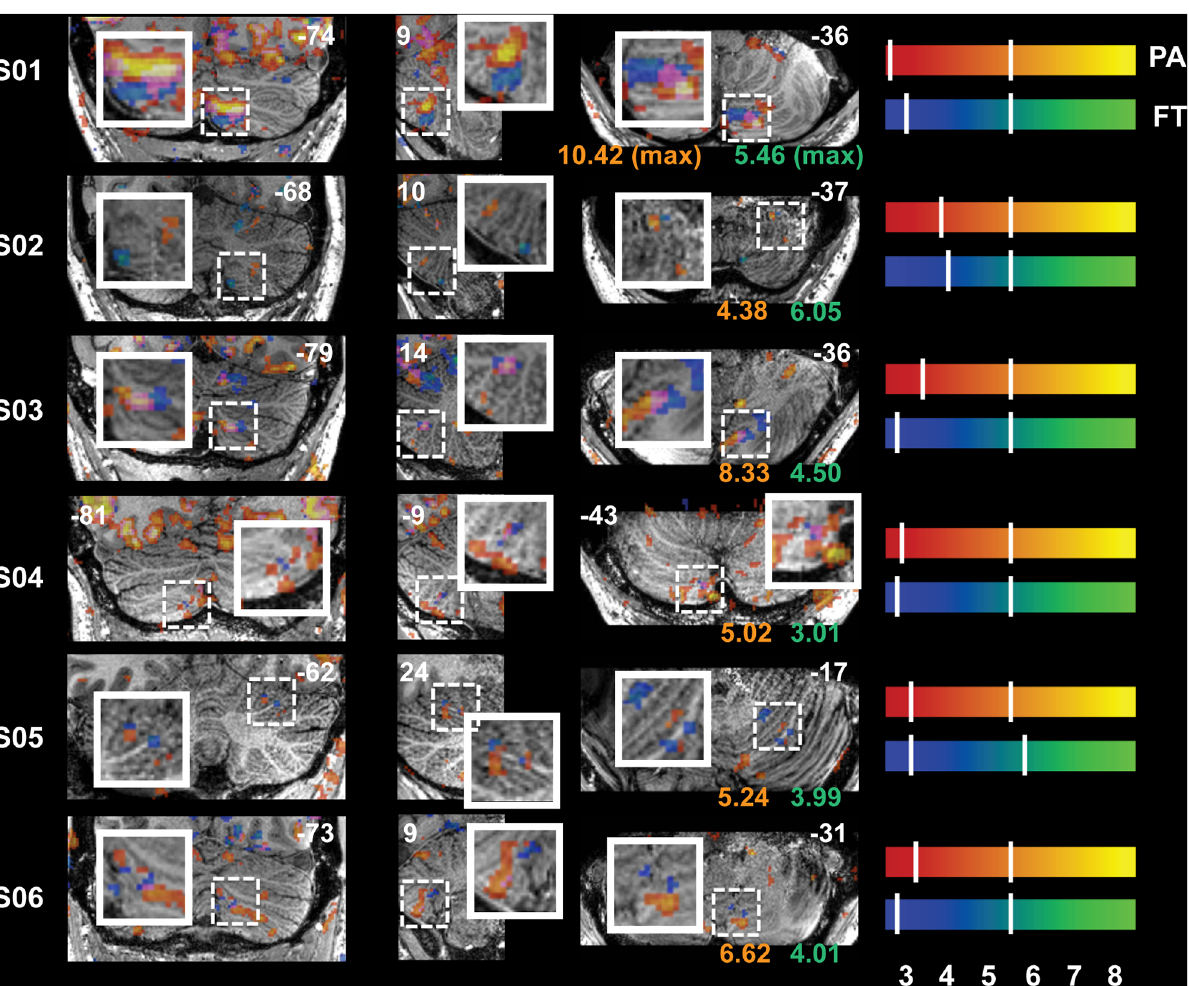
Fig 6. Functional Delineation of Task-Related Activity, Separation of Eye and Finger Movements in Ventrolateral Cb. Example of the specificity of localized activity resulting from the two motor systems (in addition to the obvious distinctions visible in Figs 2 – 5): differentiation of FT-related h VIII activity from PA-related h VIIb activity is displayed for each subject (zoomed-in area denoted by a dotted box); activations from separate tasks do not overlap. Separable activations are located more anteriorly in some subjects (S02, S05 and S06, axial slices) and the proximity and arrangement of the clusters also varies between subjects. Slice locations (in non-normalized MNI space) are displayed at the top of each panel and maximum T-values from within the zoomed areas are displayed at the bottom of the axial (rightmost) panels, color-coded by task — PA in red-orange and FT in blue-green. Refer to Fig 1a for a guide to anatomical lobule